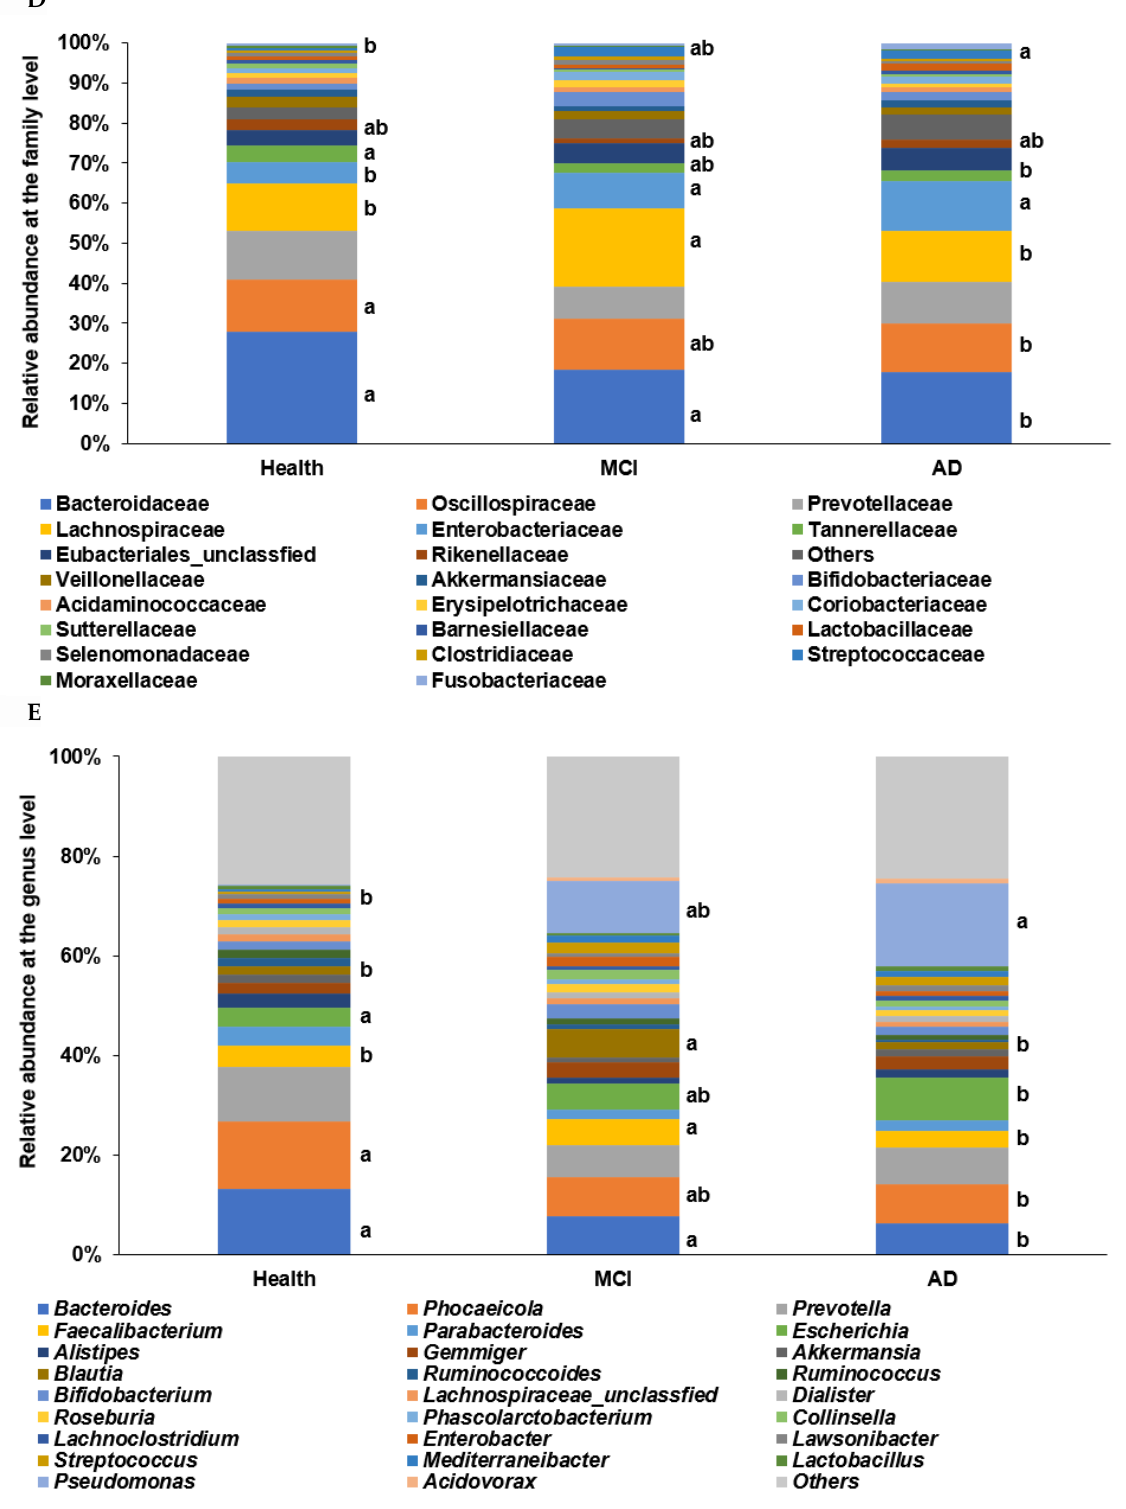
Figure 2. α -diversity, β -diversity, the relative abundance of the fecal bacteria according to the healthy, MCI, and AD groups in the participants with enterotype Bacteroides. ( A ) Chao1 index. ( B ) Shannon index. ( C ) B-diversity. Color of the circles represented the same as group names. ( D ) Relative abundance of the bacteria at the family level. ( E ) Relative abundance of the bacteria at the genus level. a,b Different letters on the bar indicated significant differences among the groups at p <